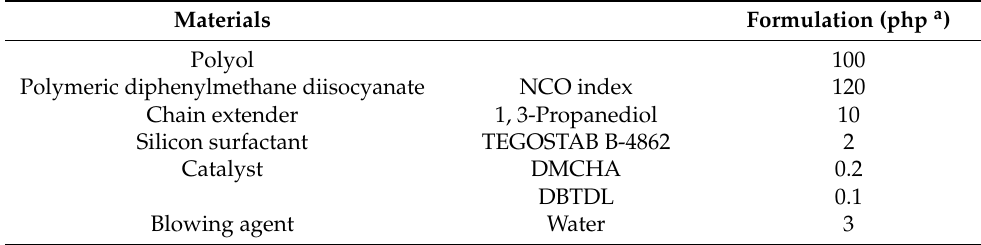
Table 1. Formulation of the polyurethane (PU) foam.